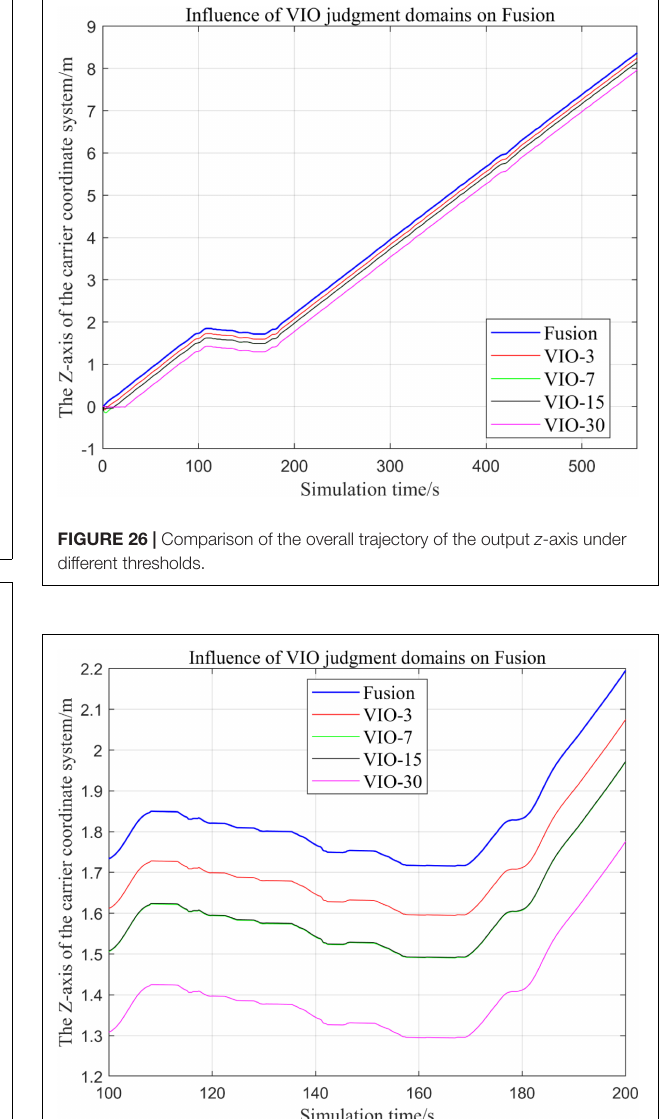
FIGURE 25 | Comparison of the overall trajectory of the output y -axis under different thresholds.